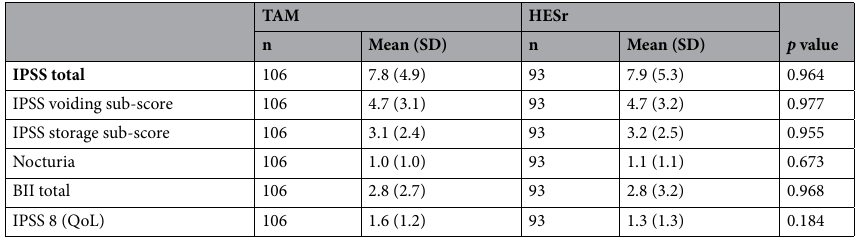
Table 4. Improvements from baseline to 6-month follow-up in symptoms, quality of life, and clinical parameters by treatment group, in patients with severe (IPSS > 19) baseline symptoms (iterative matching sample). HESr : hexanic extract of Serenoa repens; TAM: tamsulosin; IPSS: International Prostate Symptom Score; BII: Benign Prostatic Hyperplasia Impact Index; QoL: quality of life.